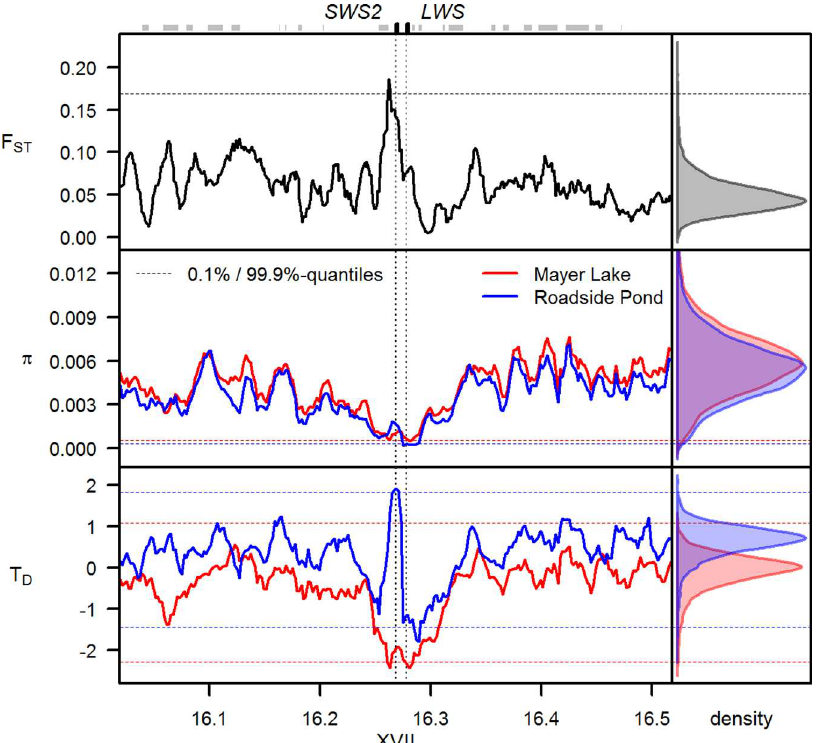
Fig 3. Signature of selective sweep in blackwater-adapted stickleback and “reversedsweep” after transplant to clearwater habitat. Significantlyreducednucleotide diversity (middle left) and Tajima’s D (T D , bottom left) in the blackwater source population Mayer Lake comparedto genome-wide expectations (right) indicatea selective sweep in this population, consistent with the signature seen across the adaptiveradiation (cf. Figs 1 and 2). After transplant to a clearwaterhabitat, however, the alternate haplotypehas increasedin frequency (Fig 2), leadingto one of the strongest differentiationsignalsin the genome(F ST , top left panel)and a significantly positive Tajima’s D. Such a pattern is consistent with a transient phase of a reversedselective sweep. Dashed horizontallines indicatethe 0.1%- and 99.9%-quantiles for each statistic based on their genome-wide distribution in regions with similar recombination rates (right panels); boxes abovethe figure indicatethe position of genes, with black boxes and vertical dashedlines highlightingthe positionof the two cone opsins SWS2 and LWS . Sliding-window F ST , nucleotide diversity and Tajima’s D values and genome- wide distributionsof each statistic can be found in S1